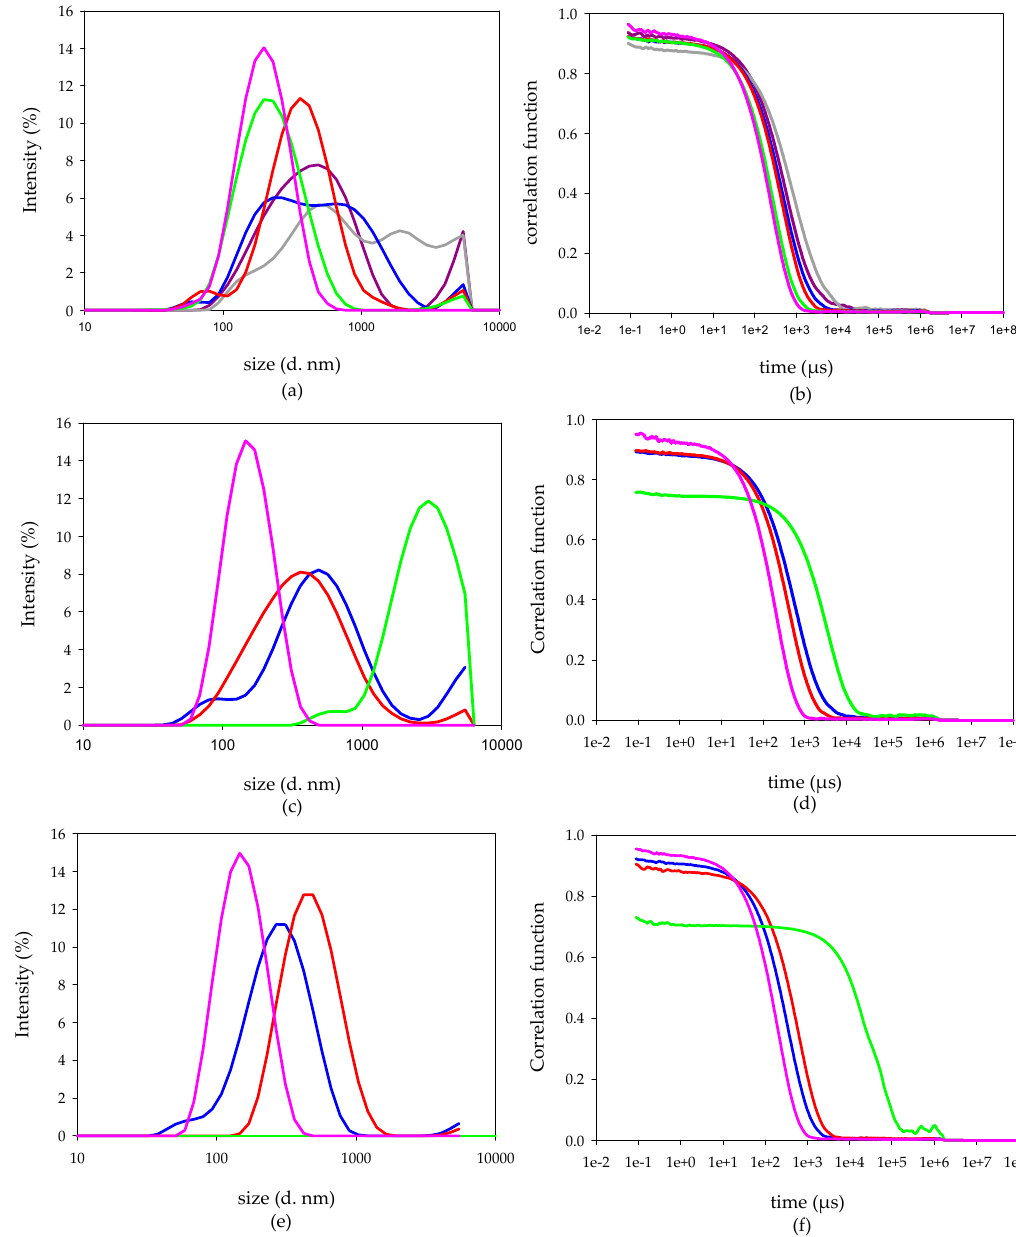
Figure 7. Hydrodynamic diameter distribution by intensity of nanocomposites obtained after adding DMTU-loaded o/w NCs to mucin solutions at mucin:P o/w NC ratios of 0.08 (w /w ) (pink), 0.17 ( w/w ) (green), 0.34 ( w/w ) (red), 0.67 ( w/w ) (blue), 1.34 ( w/w ) (grey), and 2.68 ( w/w ) (purple): ( a ) Comparison of hydrodynamic diameter and ( b ) correlogram functions of the suspensions at time 0 h; ( c ) comparison of hydrodynamic diameter and ( d ) correlogram functions of the suspensions after 1 h of incubation at 37 °C; ( e ) comparison of hydrodynamic diameter and ( f ) correlogram functions of the suspensions after 24 h of incubation at 37 °C.